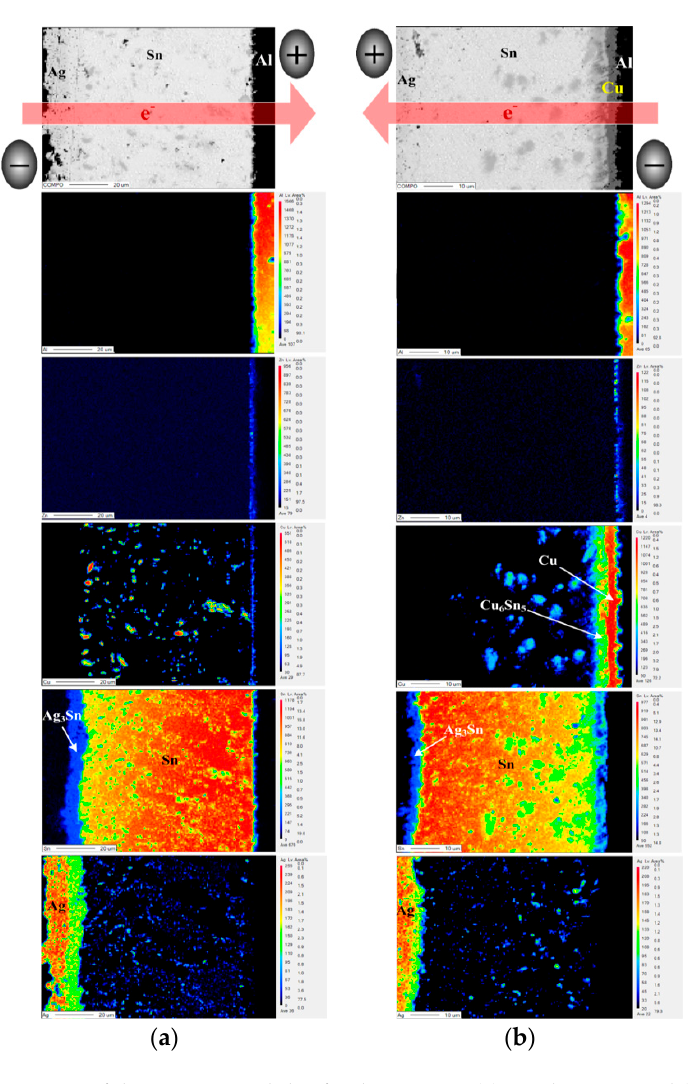
Figure 6. EMPA images of the HD PV module after bias aging: ( a ) Ag-direction and ( b ) Al-direction.